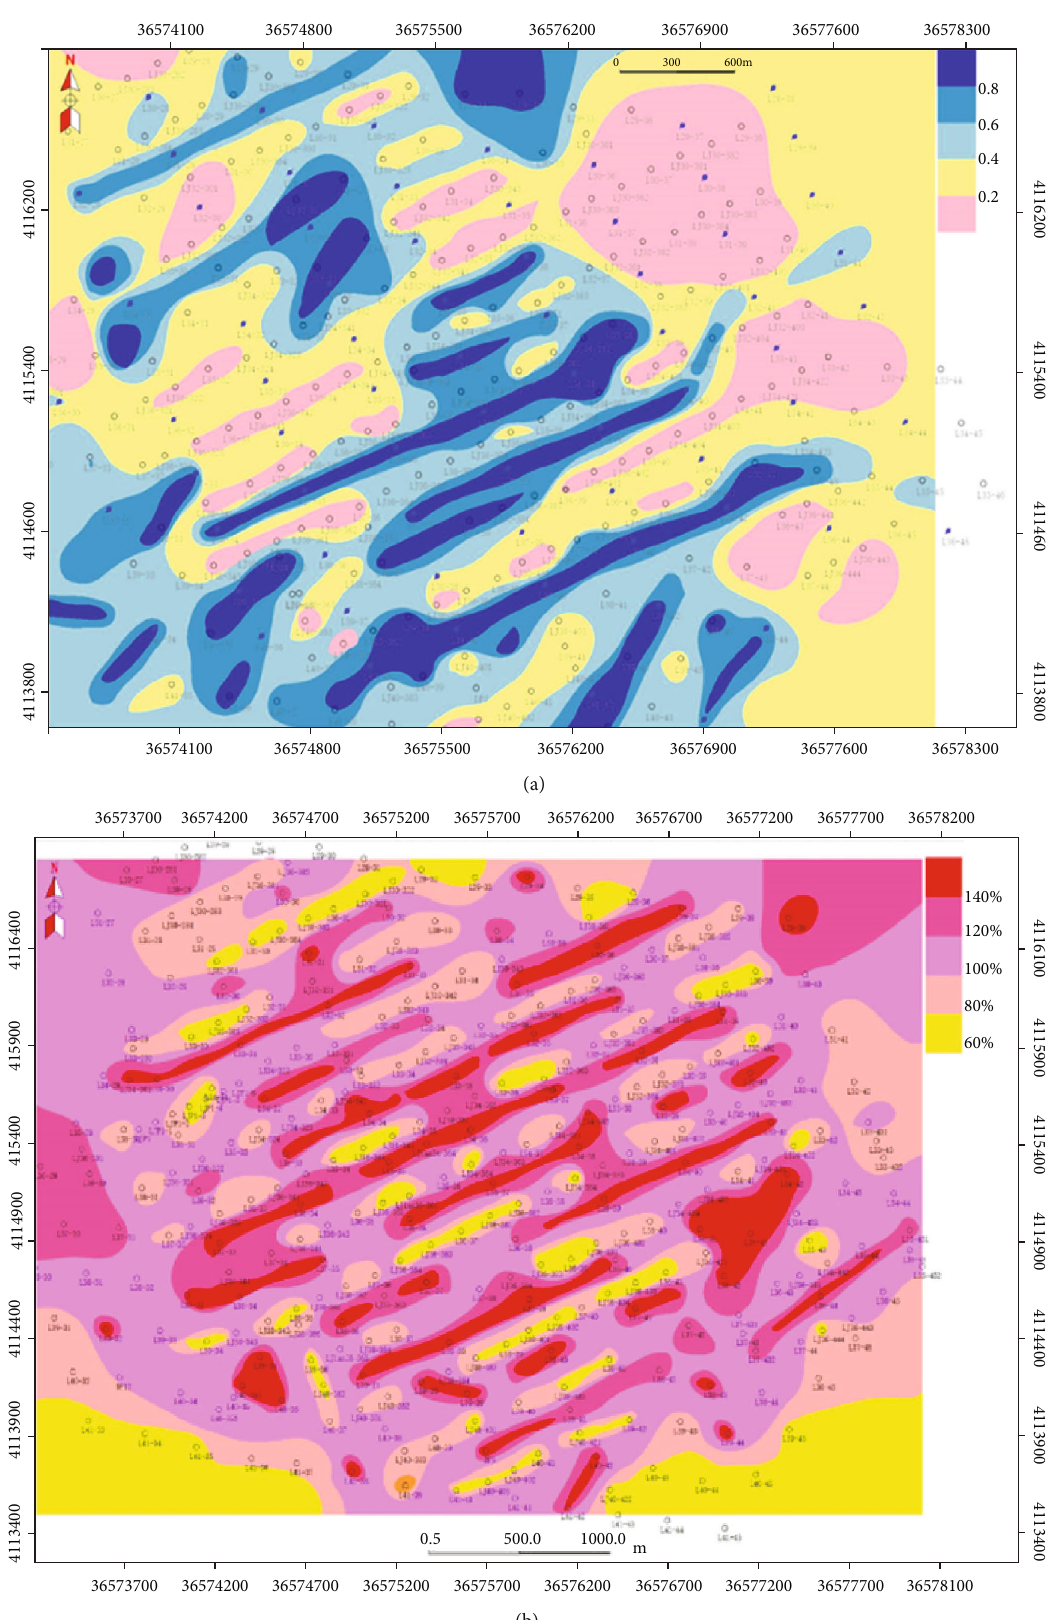
Figure 5: Schematic of (a) water cut and (b) pressure distribution of this block in